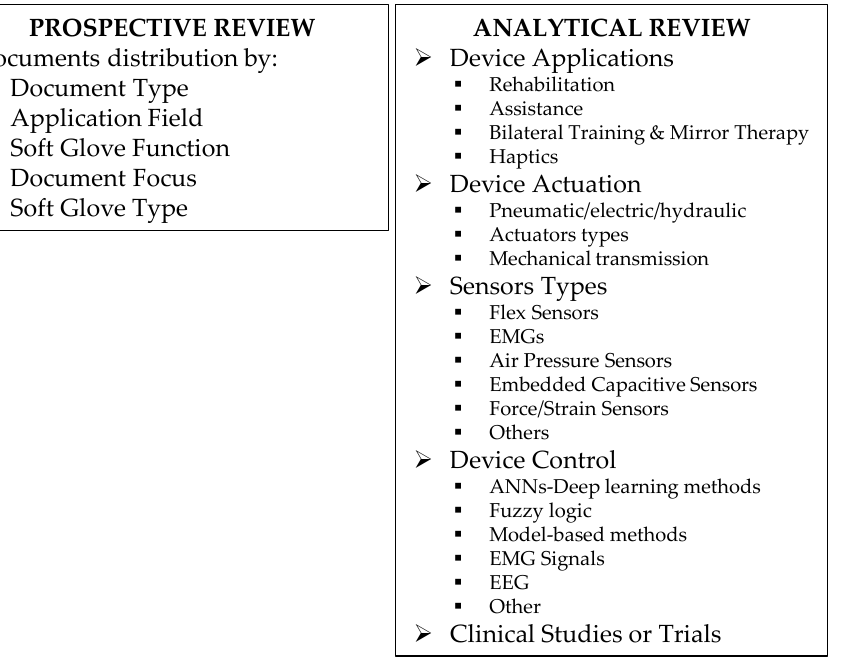
Figure 1. Schematic summary of the review work: prospective and analytical review